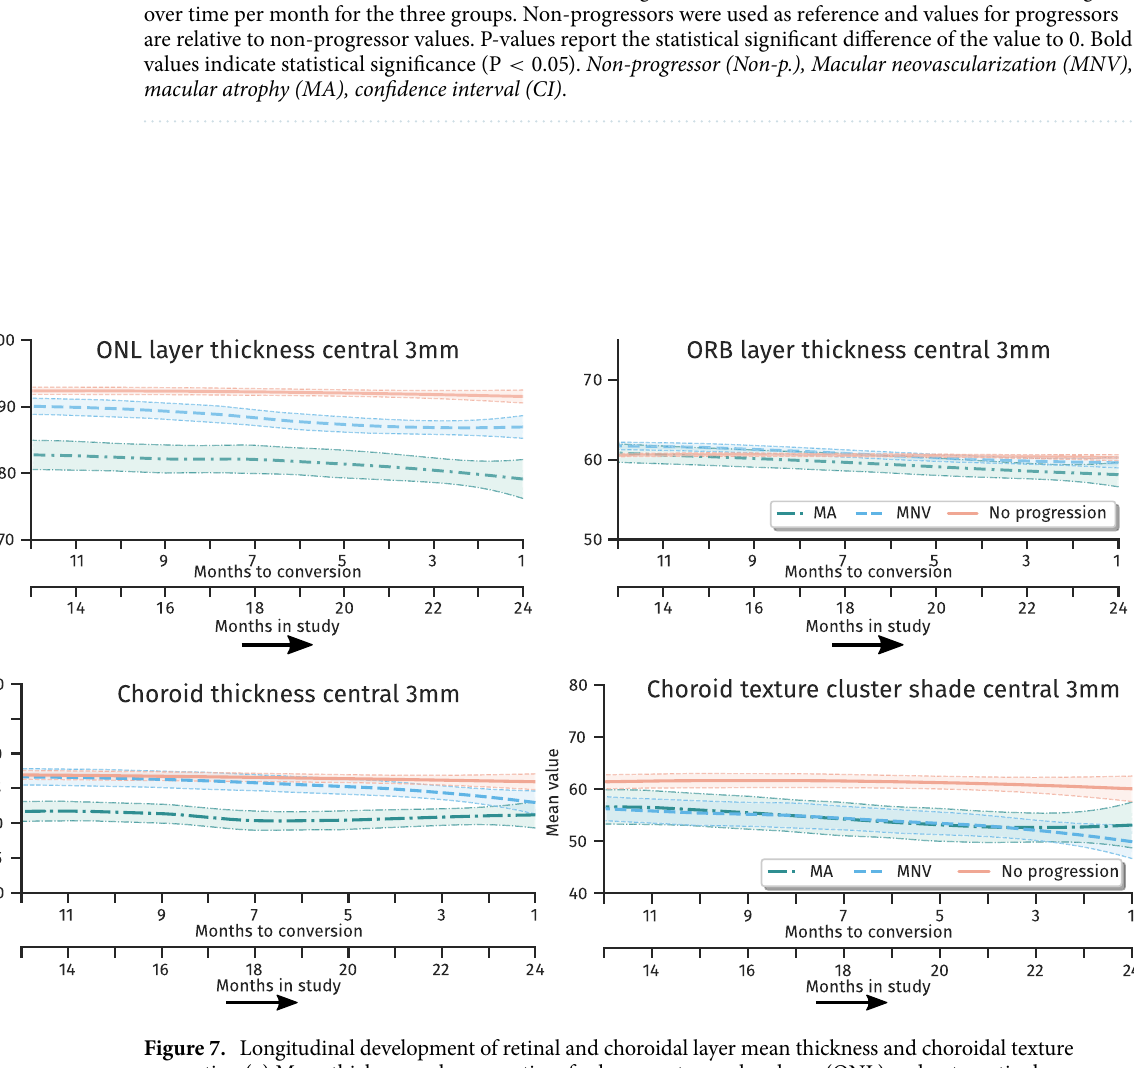
Figure 7. Longitudinal development of retinal and choroidal layer mean thickness and choroidal texture properties. ( a ) Mean thickness values over time for layers outer nuclear layer (ONL) and outer retinal hyperreflective bands (ORB) in groups macular neovascularization (MNV), macular atrophy (MA) and non- progressors. ( b ) Mean thickness and texture descriptor values over time for the choroid. Curves show the local mean thickness with respect to time to conversion for MNV and MA, and with respect to time in study for non- progressor. A local and smooth mean is obtained by LOESS. The interval shows the 0.95 confidence of LOESS